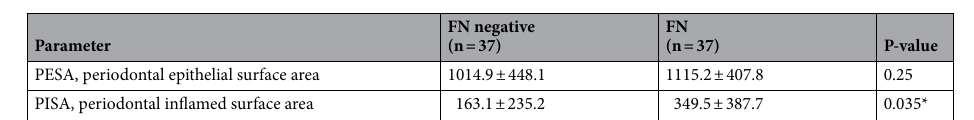
Table 5. Comparison of PESA and PISA between FN and FN negative groups. *P < 0.05 (statistically significant).